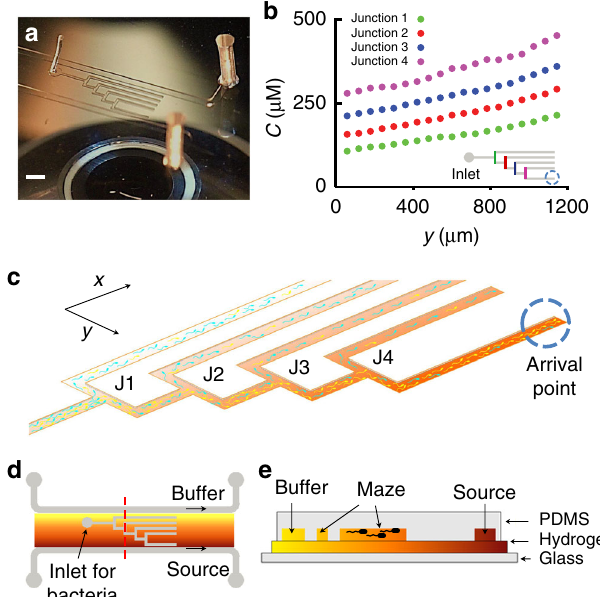
Fig. 1 The micro fl uidic T-maze. a A micro fl uidic T-maze device. The scale bar shown in the fi gure is 2 mm. b By using source and buffer channels running parallel to the maze to generate a steady chemoattractant gradient within the hydrogel base, the device creates concentration gradients that have the same magnitude through consecutive junctions (here shown for log-sensing). c Schematic of a mixed population of cells swimming through the maze. Better chemotaxers (yellow) become increasingly concentrated at sequential junctions. d Schematic of the device and e cross-section (corresponding to the red dashed line in ( d )). Flow of the chemoattractant through the source channel generates a gradient in the hydrogel, and hence also along each T-junction section (vertically oriented channel segments in ( d )) of the maze channel. A droplet containing cells is placed at the inlet shown in ( d ), and cells swim from left to right through the maze, making multiple chemotactic decisions through the consecutive